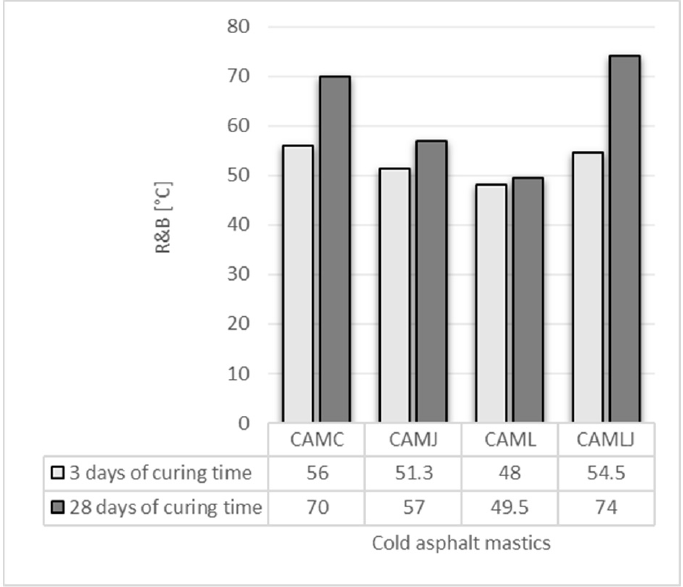
Figure 6. R&B values for cold mastics subjected to different curing time.